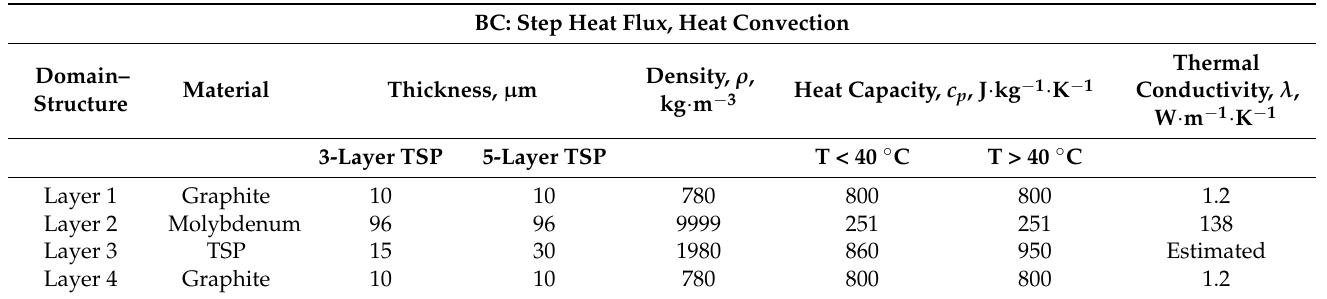
Table 2. Thermal properties of materials in 1D model of heat conduction